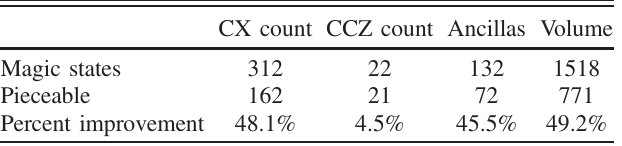
TABLE III. Resource comparison for implementing CCZ on the 7-qubit code using either magic-state injection via postse- lection or pieceable fault